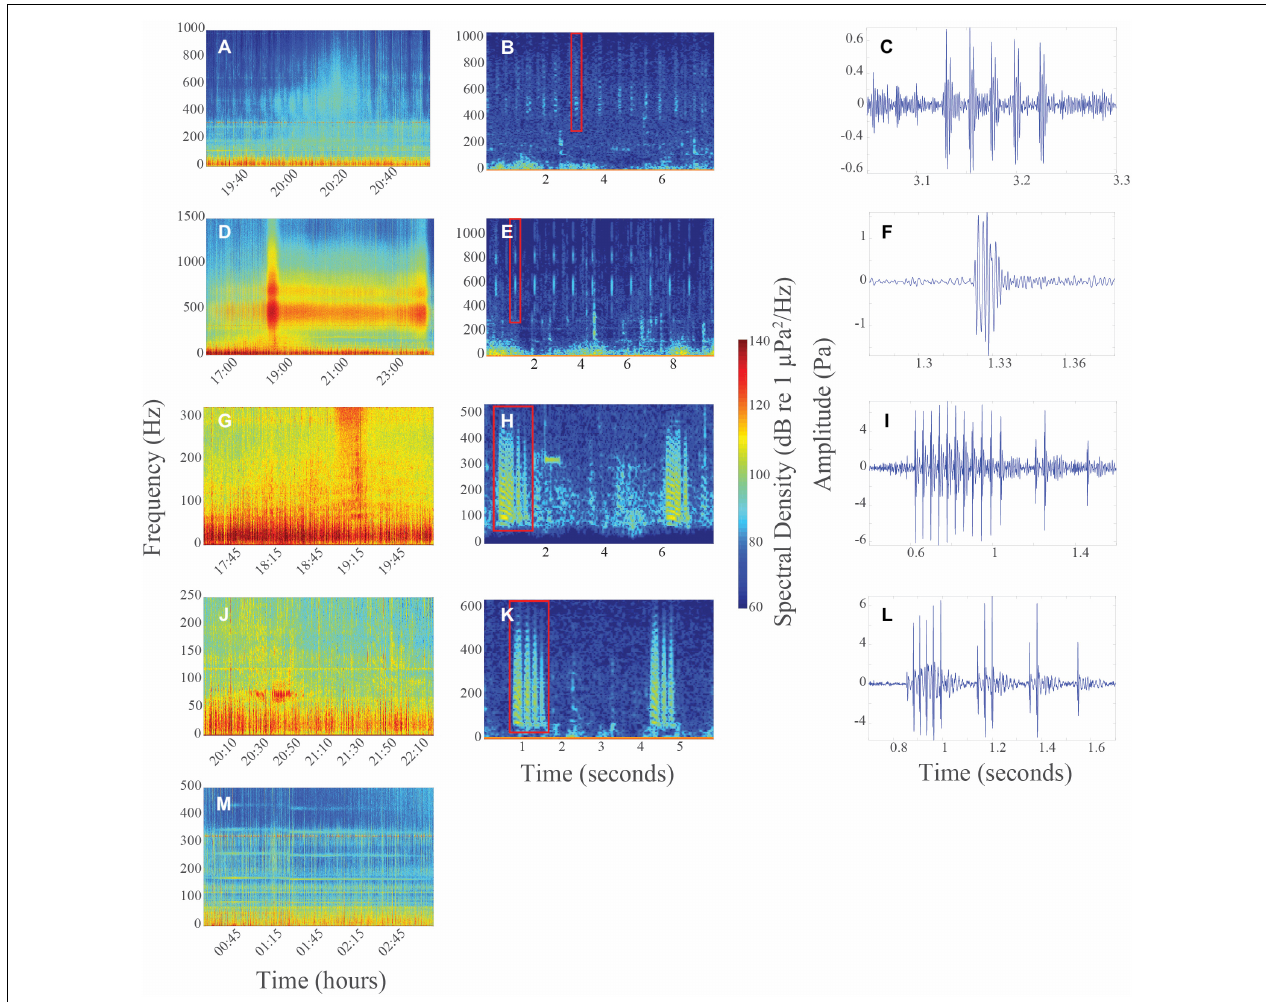
FIGURE 5 | (A) Long-term spectral average (LTSA) of Chorus I on 07/24/2017. (B) Spectrogram and (C) time series of individual call of Chorus I on 07/24/2017 at 21:10:25 (band pass filter = 395–1015 Hz). (D) LTSA of Chorus II on 07/27/2017. (E) Spectrogram and (F) time series of individual call of Chorus II on 07/26/2017 at 17:57:32 (band pass filter = 335–1115 Hz). (G) LTSA of Chorus III on 07/27/2017. (H) Spectrogram and (I) time series of individual call of Chorus III on 07/28/2017 at 19:15:04 (band pass filter = 40–535 Hz). (J) LTSA of Chorus IV on 07/22/2017. (K) Spectrogram and (L) time series of individual call of Chorus IV on 08/01/2017 at 21:25:42 (band pass filter = 25–635 Hz). (M) LTSA of Chorus V on 08/02/2017. All spectrograms used a Hanning window, f s = 48 kHz, NFFT = 8192 and overlap = 90%. Time series are of the individual calls highlighted with a red box on each spectrogram. Color in all LTSAs and spectrograms represents spectral density (dB re 1 µ Pa 2 /Hz), with red indicating highest received levels. Times are reported in Pacific Standard